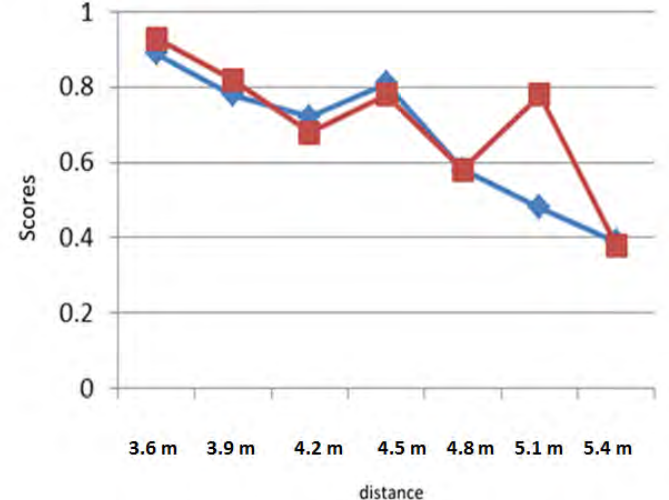
Figure 4. Actual success rates (blue line) from each of the seven positions for the group and predicted values based on regression analysis are displayed (red line) on the second